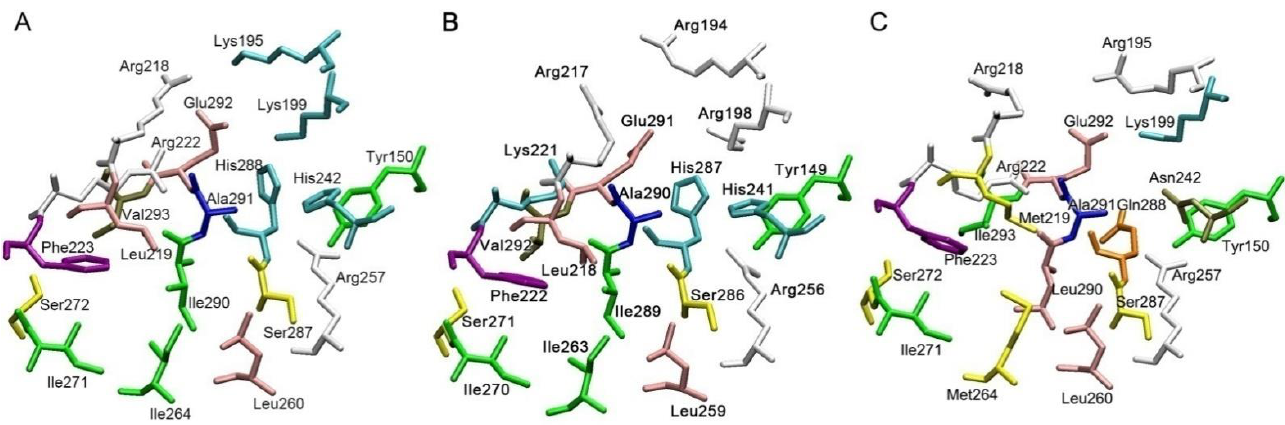
Figure 2. Structures of Sudlow site I of HSA ( A ), BSA ( B ) and RSA ( C ).